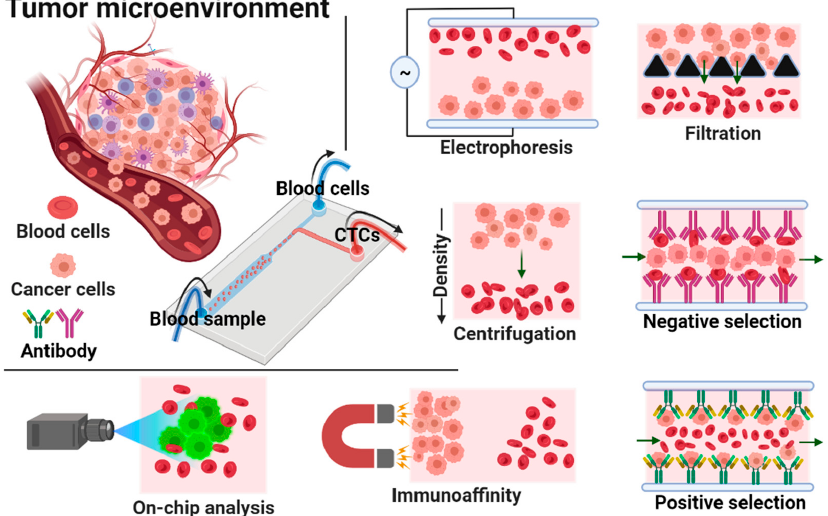
Figure 1. Range of methods involved in physical and biological approaches for early-stage detection and isolation of